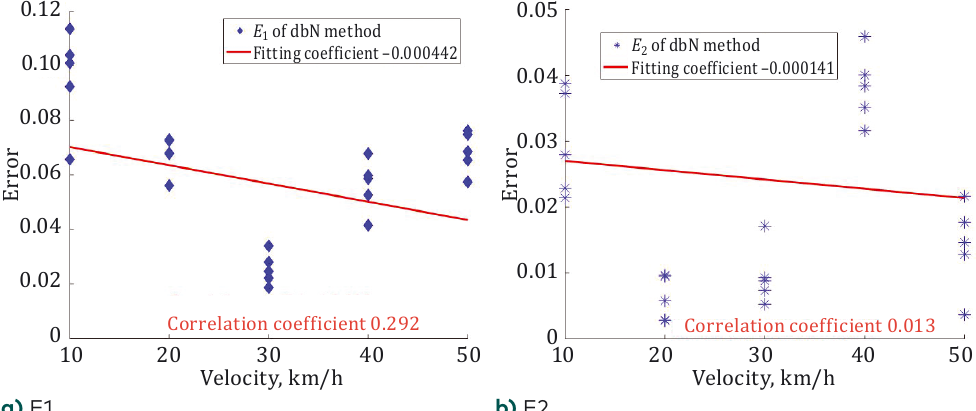
Figure 10. Error analysis of the dbN